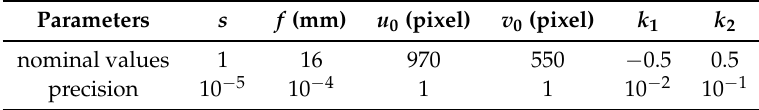
Table 1. The nominal values and precision of the